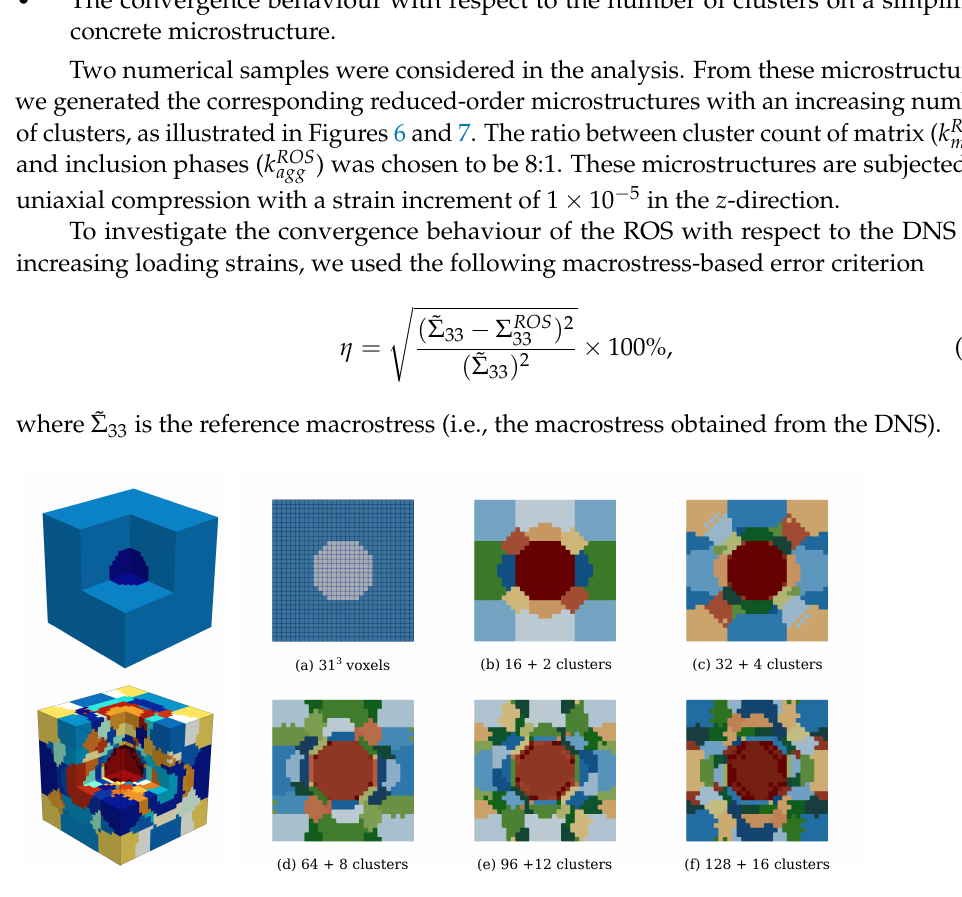
Figure 6. Simple 3D model structure characterised by a cube (size 3.1 cm) with one spherical inclusion at the center and the corresponding clustered microstructures corresponding to various numbers of clusters. The spherical inclusion has the radius of 0.64 cm and occupies a volume fraction of 4.582%. Each color represents a different cluster